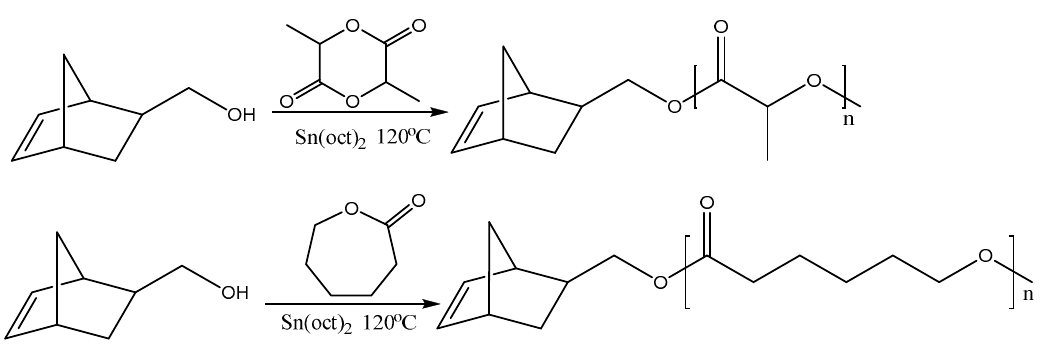
Figure 10. Examples of the syntheses of α -monotelechelic macromonomers of PLLA and PCL. (b) ω -monotelechelic macromonomers. There are two ways to synthesize these macromonomers: